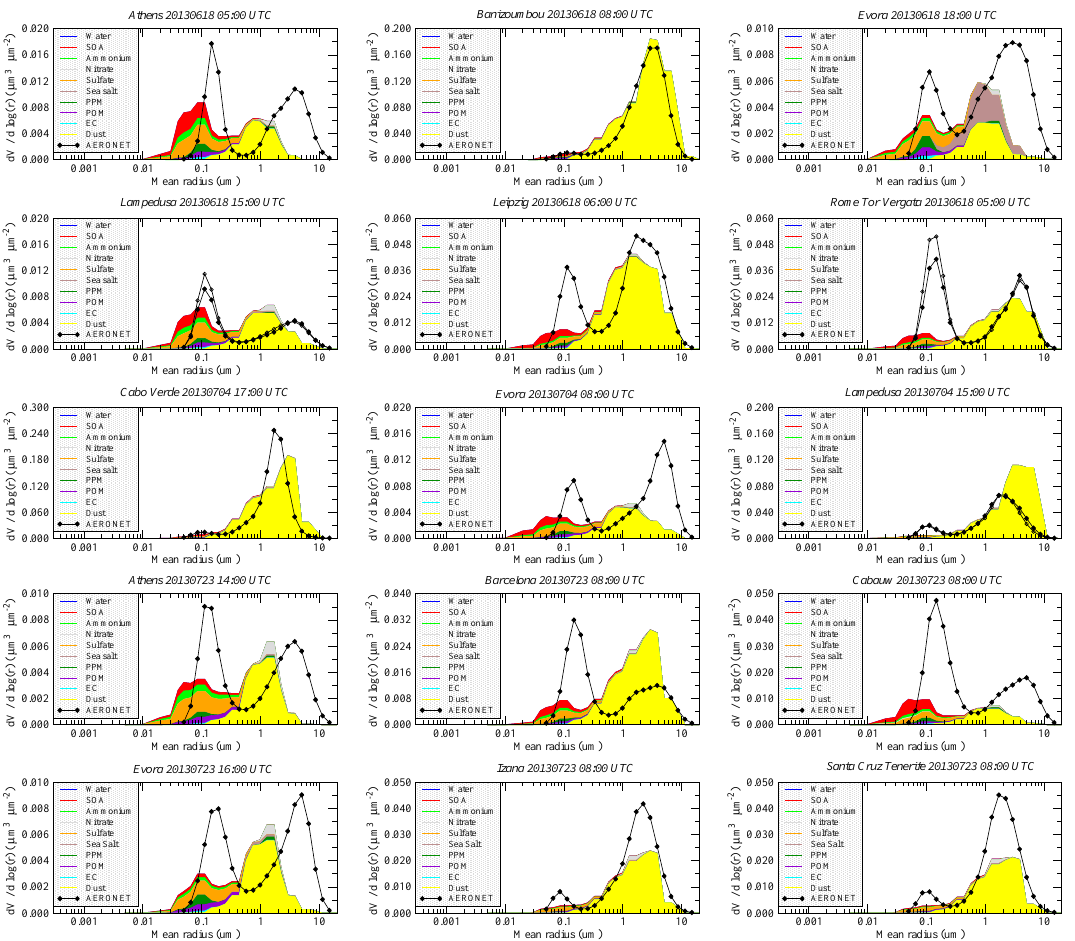
Figure 9. Comparisons between observed (AERONET) and modeled (CHIMERE) aerosol size distribution for 18 June, 4 and 23 July 2013. For the model results, the aerosol speciation is displayed with different colors for each species.